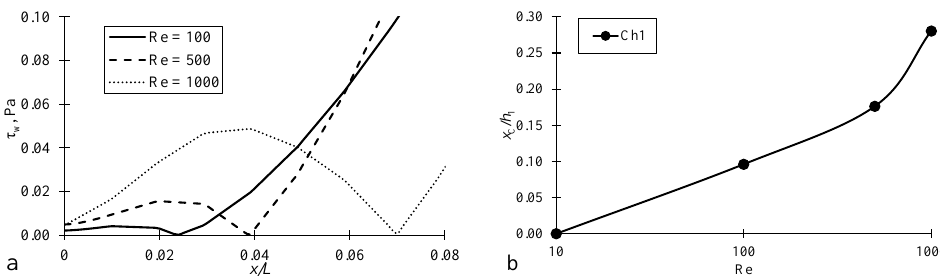
Figure 7. Wall shear distribution on the bottom of Ch1 ( a ) and x C dependency on Re ( b ).